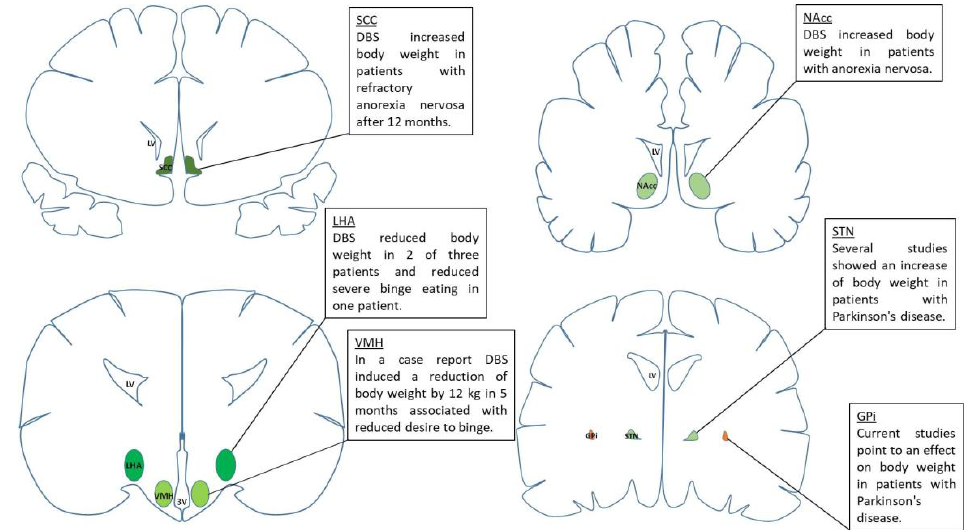
Figure 1. Schematic overview of human studies investigating the role of deep brain stimulation (DBS) in several brain areas to modulate food intake and body weight. The lateral and the ventromedial hypothalamus could be targeted in obese patients and stimulation might be useful to reduce the desire to binge. The nucleus accumbens, subcallosal cingulate and the subthalamic nucleus are potential brain areas that could be targeted in the treatment of anorexia nervosa. Abbreviations: 3 V, third brain ventricle; GPi, globus pallidus internus; LHA, lateral hypothalamus; LV, lateral brain ventricle; NAcc, nucleus accumbens, SCC, subcallosal cingulate; STN, subthalamic nucleus; VMH, ventromedial hypothalamus.